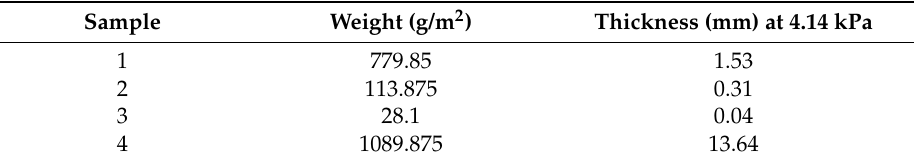
Table 4. Basic structural features of test samples for the precision test.